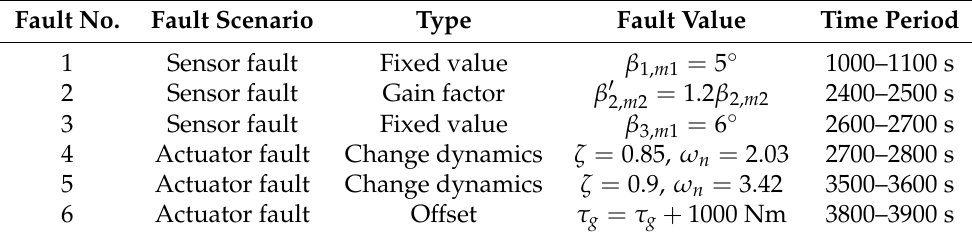
Table 2. The setting values of considered fault